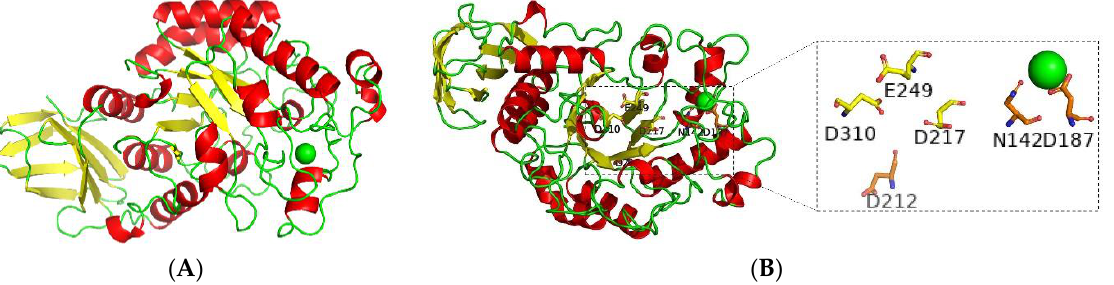
Figure 6. The homology structural model of the BvAmylase. ( A ) The structural model of the BvAmylase. The α -helices, β -folds, and coils are shown in red, yellow, and green, respectively. ( B ) The conservative catalytic and Ca 2+ binding sites. Residues of the catalytic triad are shown in yellow. The Ca 2+ binding sites are shown in orange, while the Ca 2+ is displayed as a green ball.